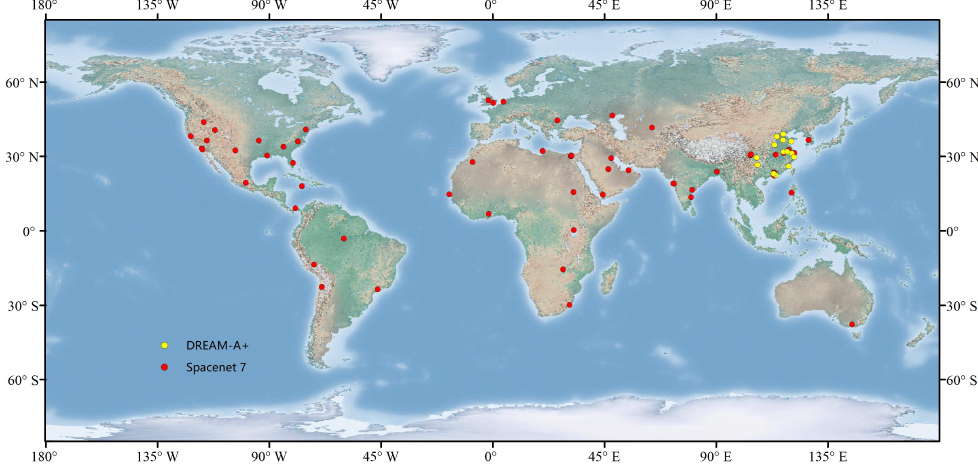
Figure 8. Distributions of images and the corresponding ground truths in the proposed